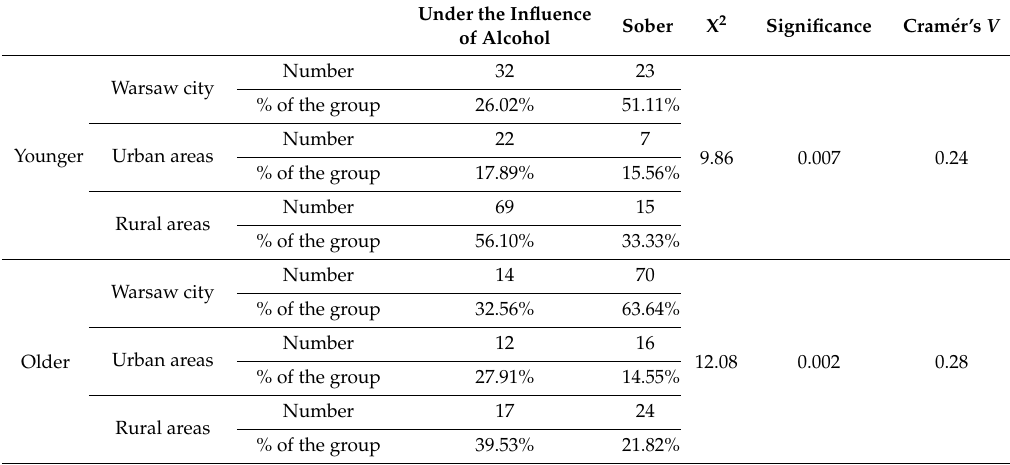
Table 4. Number of victims by group, location of accident, and age